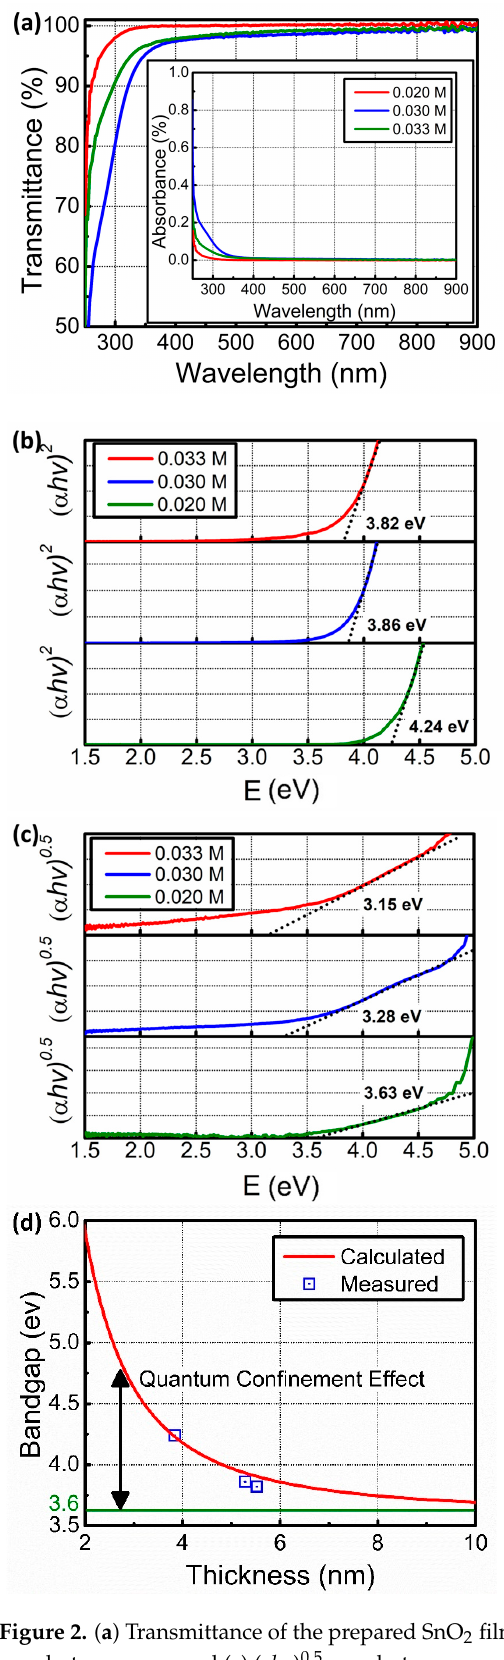
Figure 2. ( a ) Transmittance of the prepared SnO 2 films; the inset shows absorbance spectra. ( b ) ( ahv ) 2 vs. photon energy and ( c ) ( ahv ) 0.5 vs. photon energy for prepared SnO 2 films. ( d ) Energy bandgap as a function of the precursor concentrations.